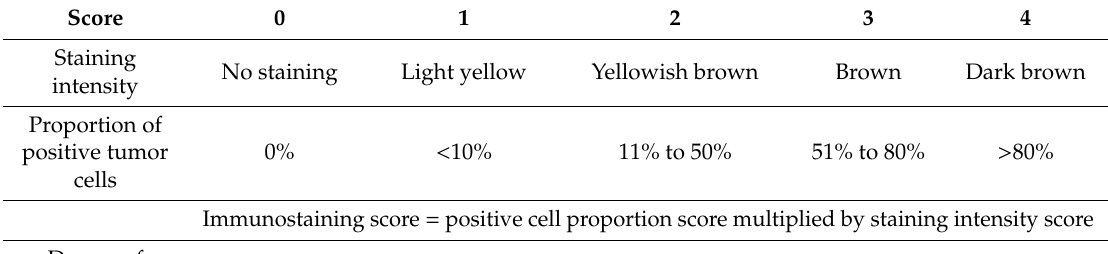
Table 4. p53 immunostaining